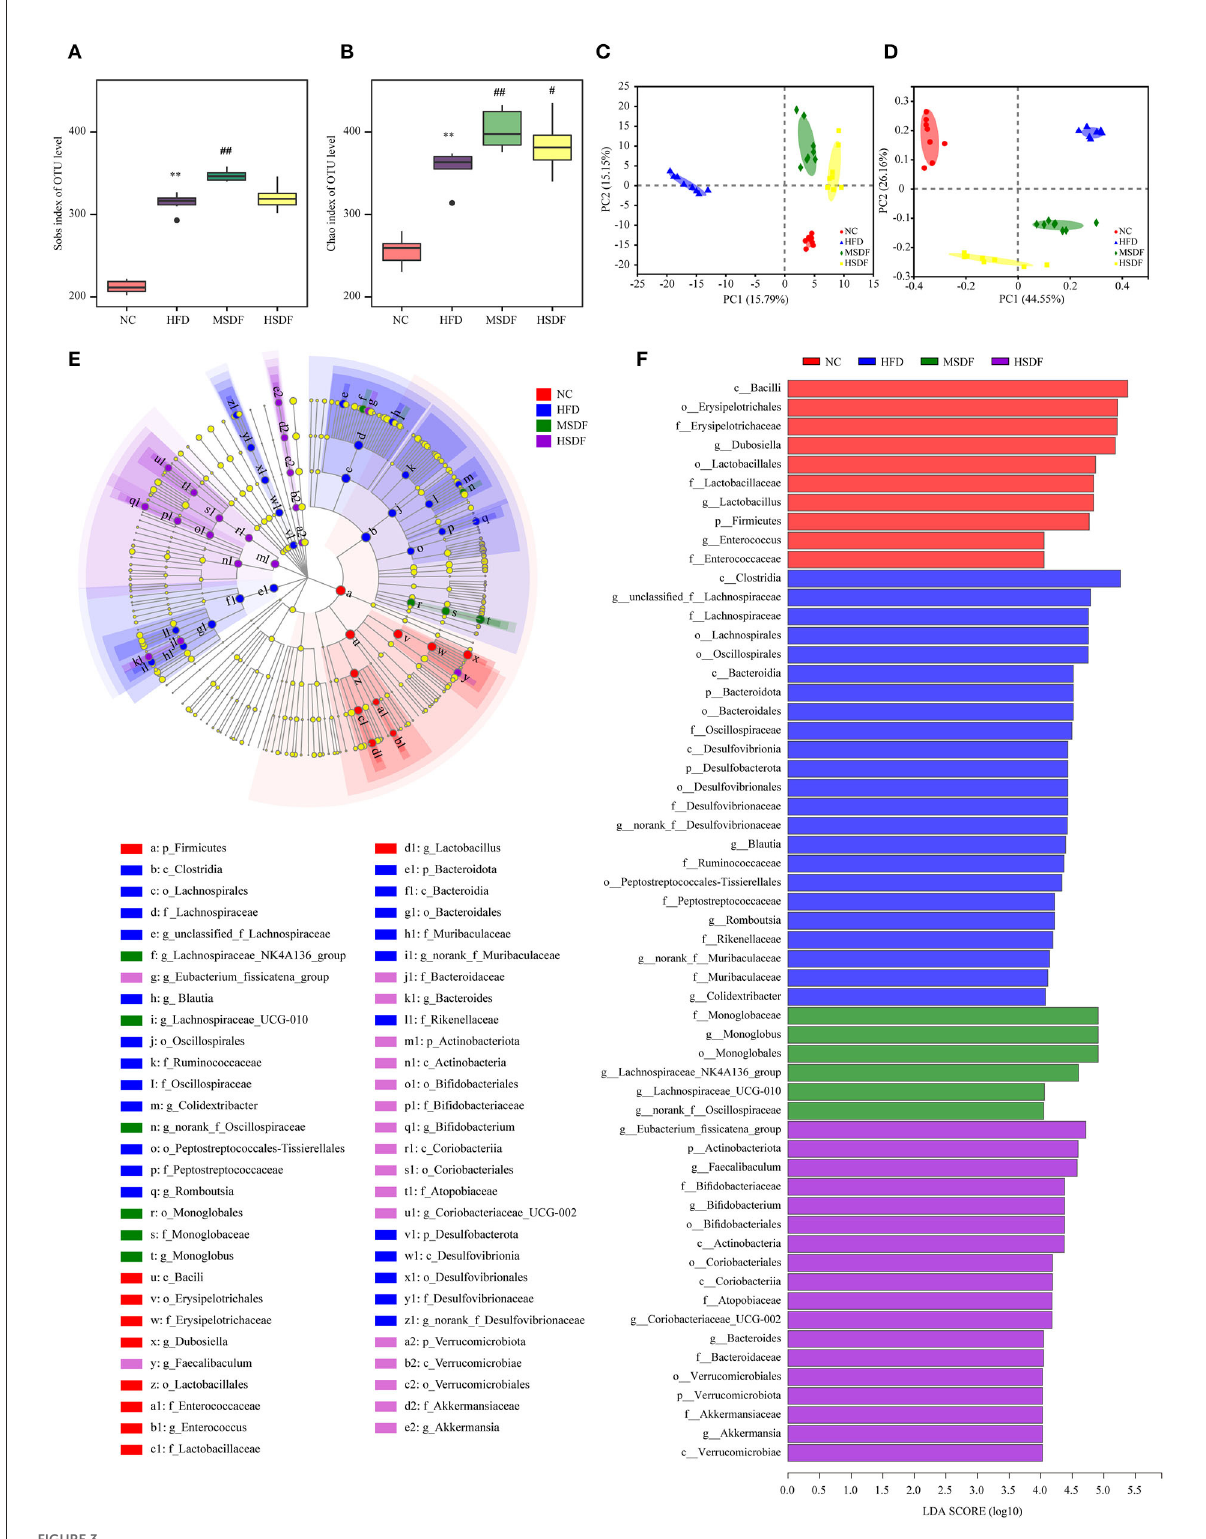
FIGURE3 Effect of PP-SDF administration on the structure of the gut microbiota. Alpha diversity was evaluated by Chao and Sobs index. (A) Sobs index at 12 weeks. (B) Chao index at 12 weeks. (C) PCA of bacterial community composition at 12 weeks. (D) PCoA plot of weighted UniFrac distance at 12 weeks. (E) Cladogram generated from LEfSe analysis. (F) Linear discriminant analysis (LDA) scores. NC: 10% fed on a low-fat diet, oral